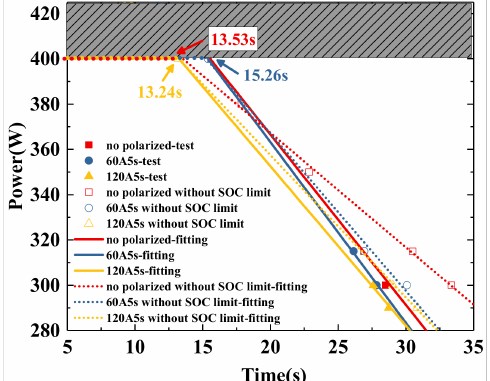
Figure 16. Constant power pulse test results with initial polarization at 10 degrees